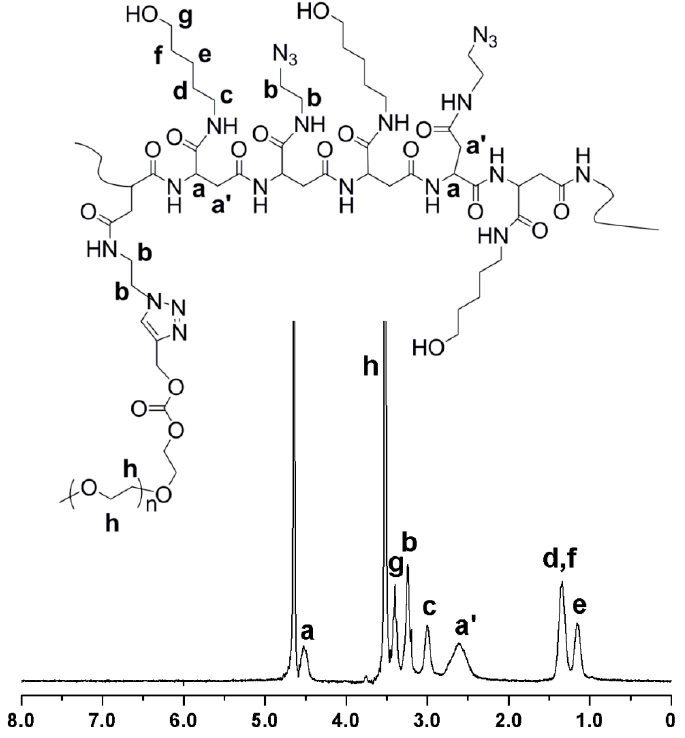
Figure 2. 1 H NMR spectrum of mPEG ‐ PAAH in D 2 O.